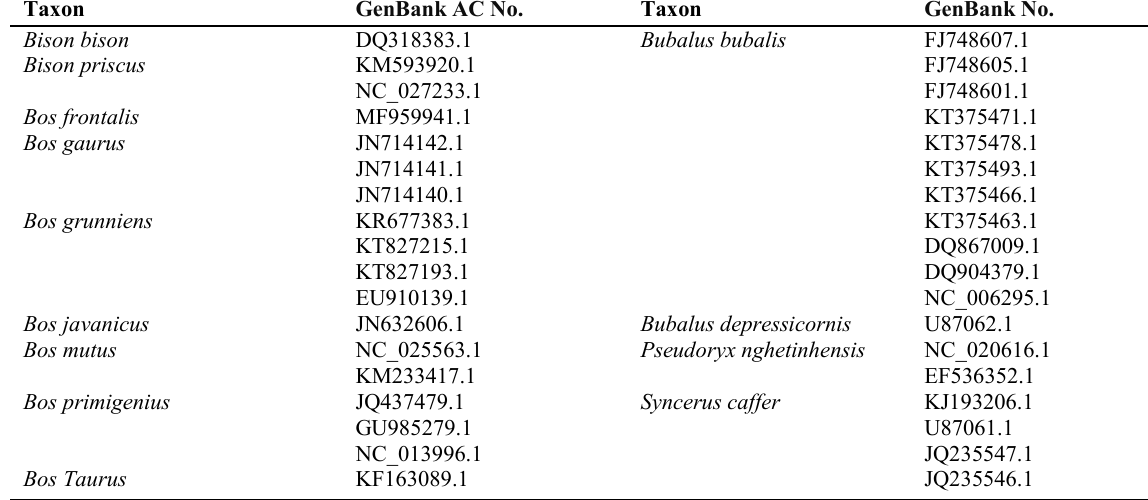
Table 4. The list of 16S rRNA gene samples (in alphabetical order) with GenBank accession number (n=36) .